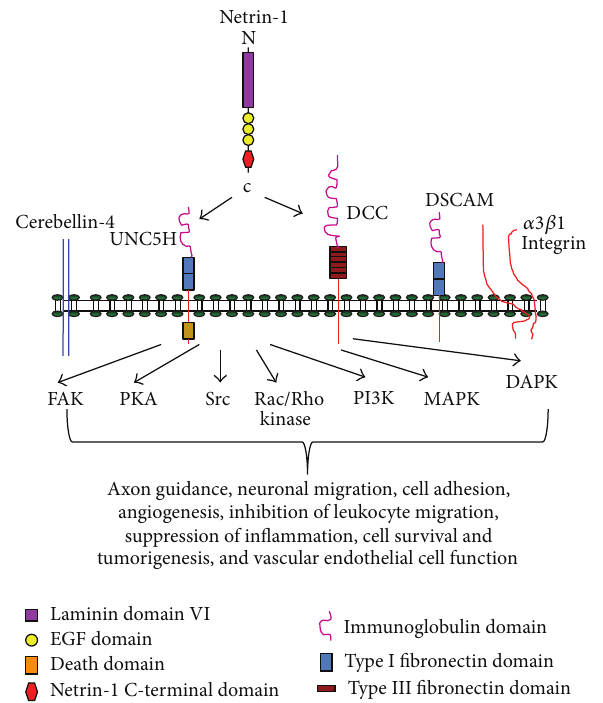
Figure 2: Netrin-1 receptor signaling and known functions. Netrin- 1 is known to bind several receptors which include uncoordinated 5 H (UNC5H1-4), deleted in colorectal cancer (DCC), down syn- drome cell adhesion molecule (DSCAM), integrins ( 𝛼 3 𝛽 1 & 𝛼 6 𝛽 3), and cerebellin-4. Binding of netrin-1 to these receptors is known to activate several signaling pathways including focal adhesion kinase (FAK), protein kinase A (PKA), src kinase, Rac/Rho kinase, phosphorinositol3-phosphateactivatedkinase(PI3K),andmitogen activated kinase (MAPK). Death associated protein kinase (DAPK) activation occurs in the absence of ligand binding. Activation of these pathways was associated with changes in cellular function listed in the